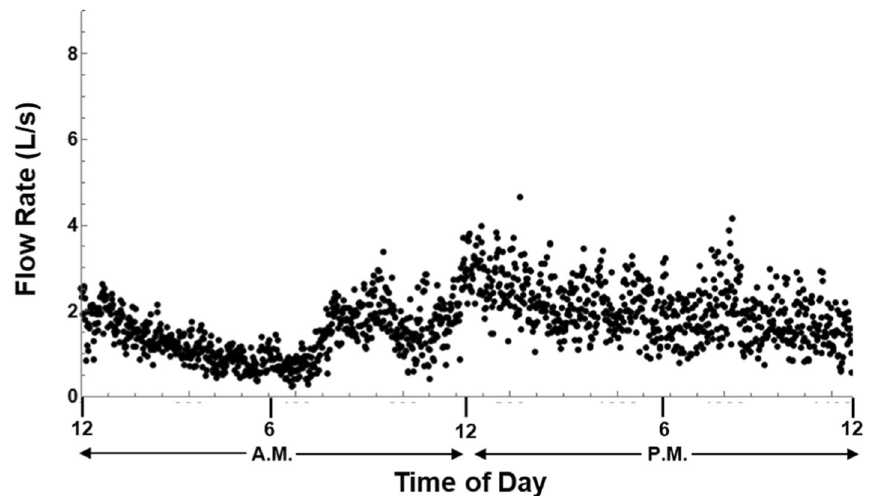
Fig. 11 Wednesday average readings for daily flow